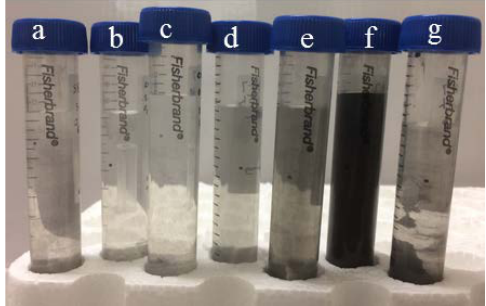
Figure 3. Photograph of centrifuge tubes showing exfoliated samples in different sonication and ozone treatment times: ( a ) 15 h sonication with 1 h continuous ozone treatment; ( b ) 3 h sonication with 2 × 10 min intermittent ozone treatment; ( c ) 6 h sonication with 3 × 10 min ozone treatment; ( d ) 9 h sonication with 4 × 10 min intermittent ozone treatment; ( e ) 12 h sonication with 5 × 10 min intermittent ozone treatment; ( f ) 15 h sonication with 6 × 10 min intermittent ozone treatment; ( g ) 15 h sonication without ozone treatment.